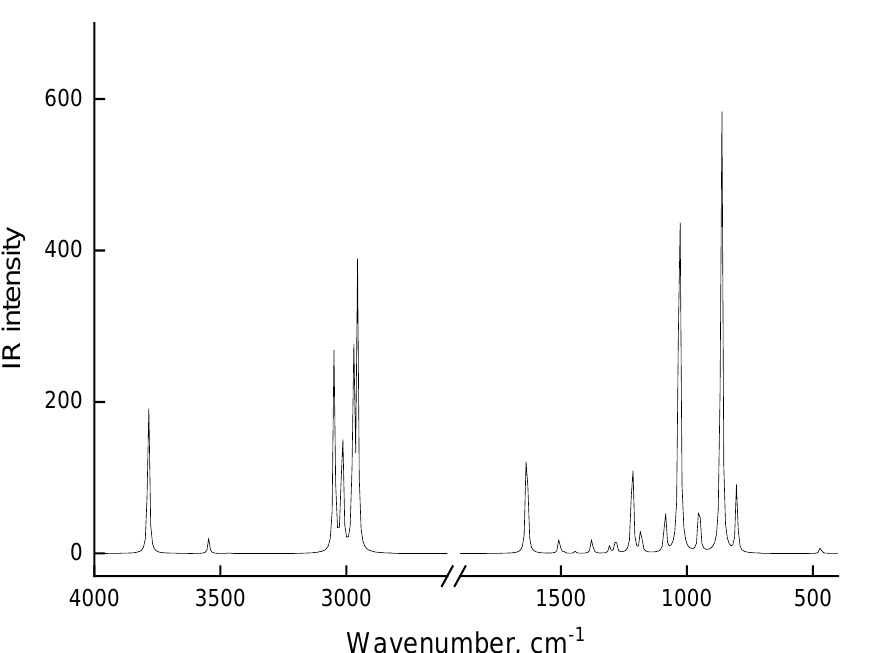
Figure 3. Theoretical IR spectrum of a flat transoidal model of the MEA. Calculations show the possibility of MEA associate existence as dimers and linear trimers, with the formation of O-H . . . N hydrogen bonds between individual MEA molecules. The lengths of such hydrogen bonds are 2.1 Å in dimer and 2.3 Å in trimer forms. In this case, the association energy drops from 3.73 kcal/mol in the dimer to 3.28 kcal/mol in the trimer. According to the calculations, MEA tetramer already has a more complex structure: three molecules form a cyclic associate, and the fourth molecule is not associated with a cyclic trimer. Theoretical vibrational spectra of such associates are already in good agreement with the experimental IR spectrum of MEA shown in Figure 1a, especially if we compare the experimental IR spectrum with the superposition of theoretical spectra of two or three different models of associates.